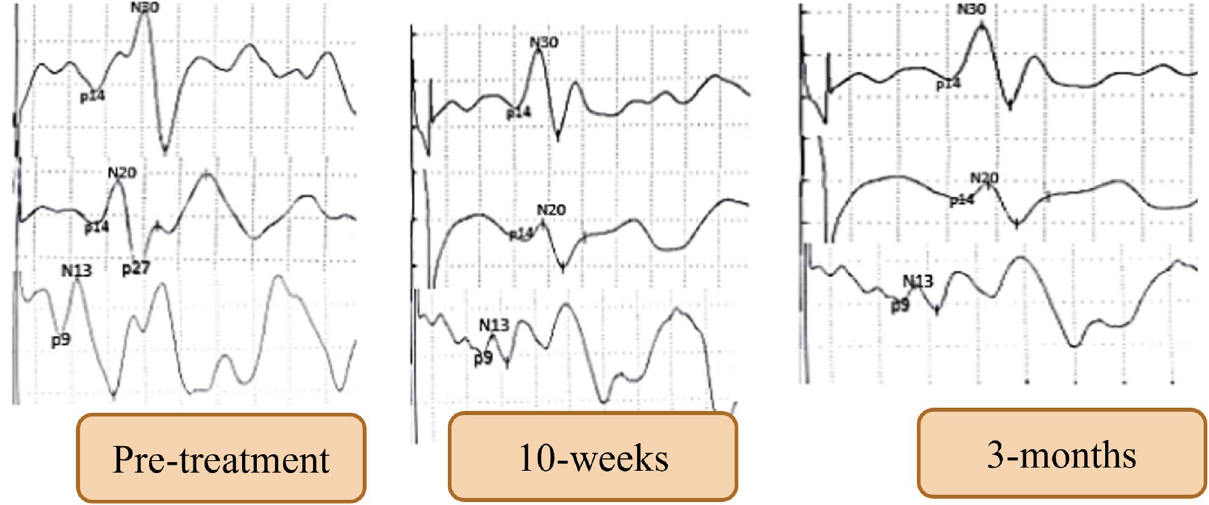
Figure 3. A representative example of spinal, cortical and sub-cortical findings at three intervals of measurement: baseline or pre-treatment, following 10-weeks of treatment, and 3-month follow-up.